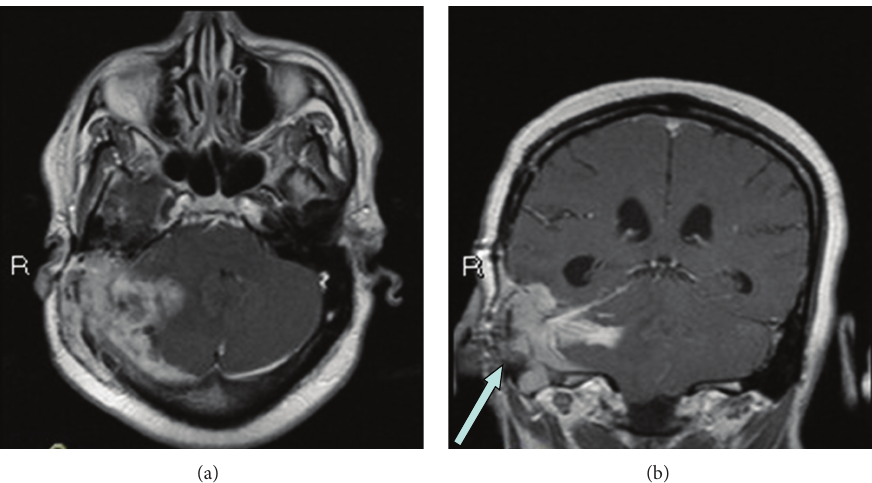
Figure 3: Axial and coronal postcontrast T1 weighted images show the extent of supratentorial and infratentorial enhancement. The coronal image clearly shows the invasion of the right sigmoid sinus (arrow).